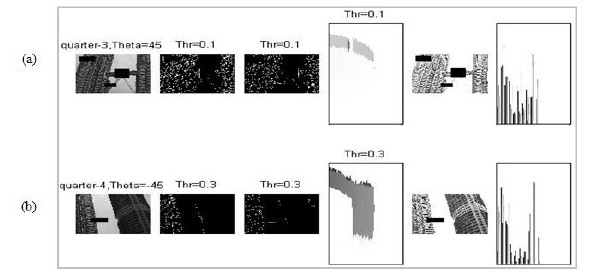
Fig. 11. Test image gradients: (a) Vector angle = 45 °, threshold to the vertical and horizontal gradients = 0.1, filter correlation, with a histogram of those gradients, (b) theta = - 45, TH = 0.3 filter correlation, with a histogram of those gradients.